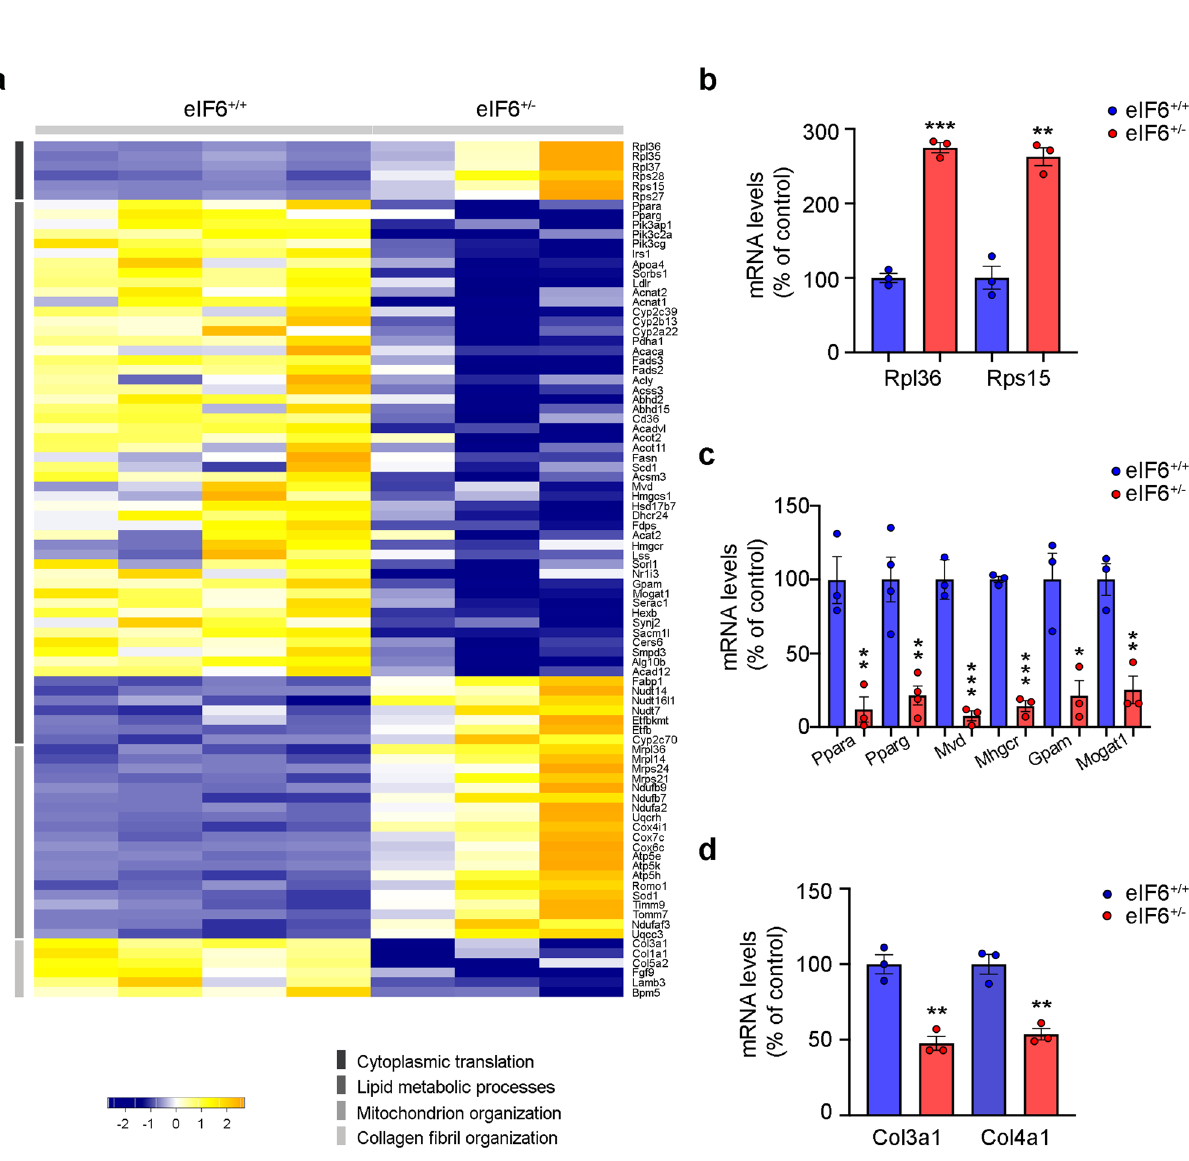
Fig. 4 eIF6 haploinsuf fi ciency affects hepatic lipogenesis. a Heatmap of differentially expressed genes in eIF6 + / − versus eIF6 + / + livers: each column represents a single liver sample. Read count differences are visualized as Z -scores. Genes are clustered in four indicated biological processes. b – d Real- Time PCR analysis of selected targets validates RNA-Seq data ( n = 3 for genotype). Data are represented as means ± SD. Two-tailed t test. ** p value ≤ 0.01, *** p value ≤ 0.001. Data are provided as a Source Data File.